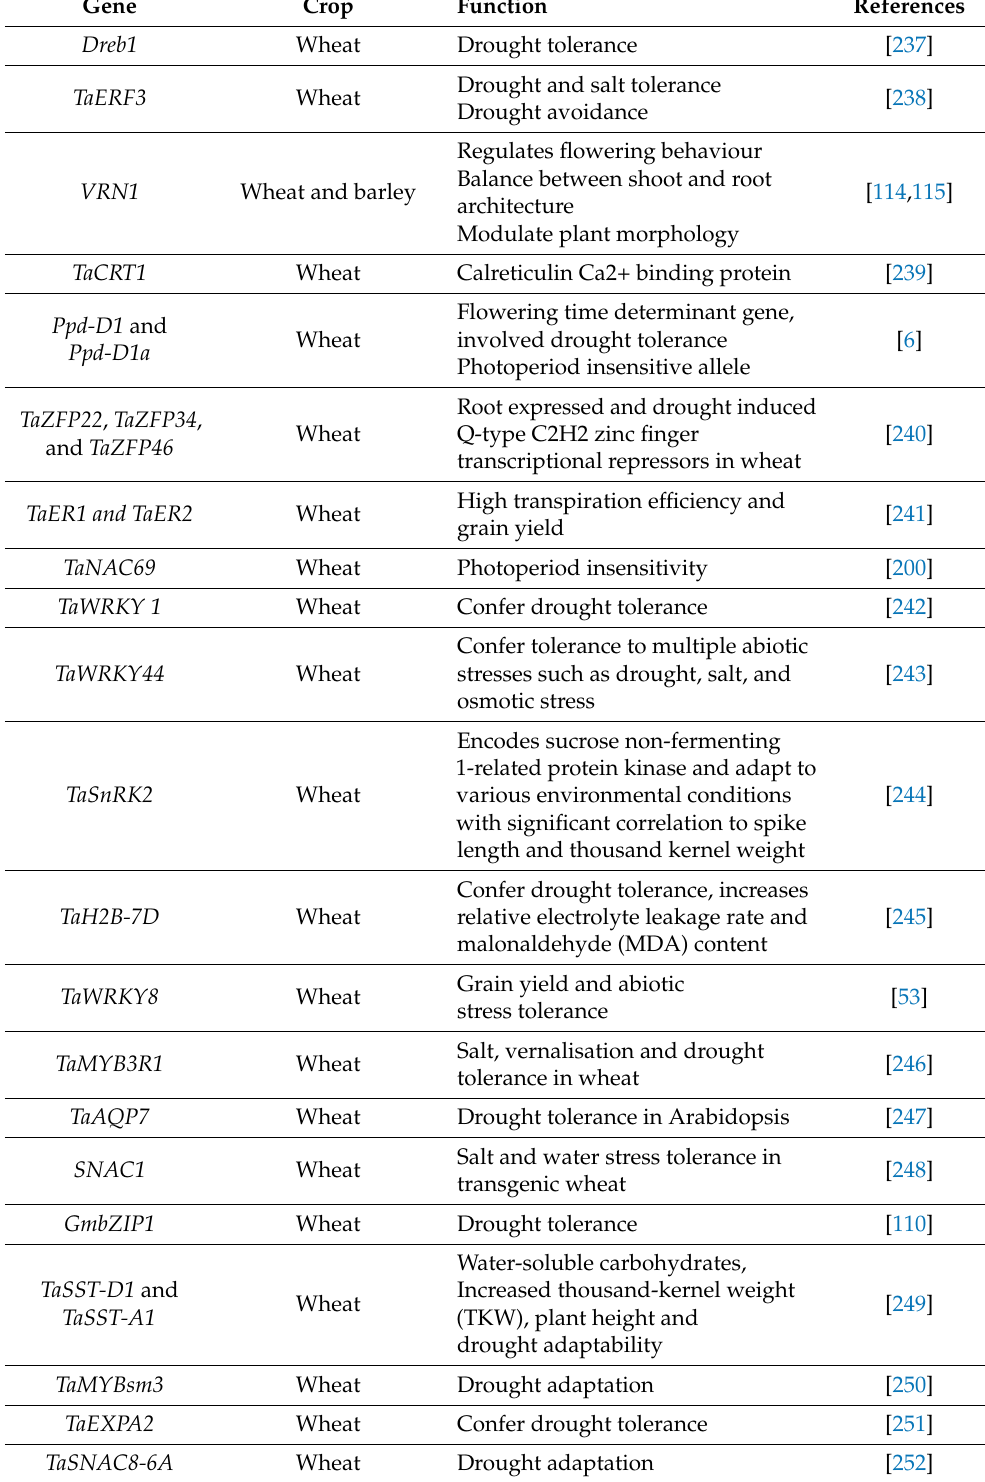
Table 5. Putative genes associated with target agro-physiological traits conditioning drought tolerance. Gene Crop